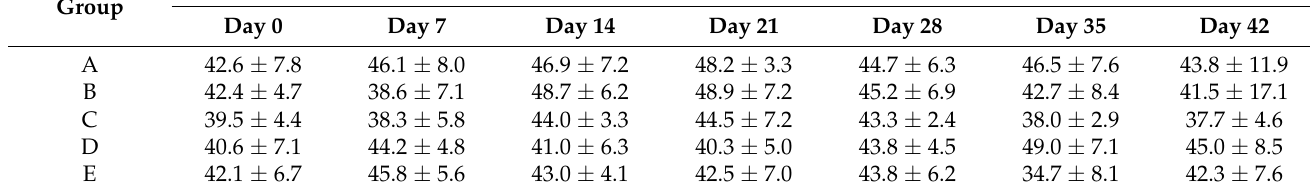
Table 2. Levels of plasma SGPT in rats fed with normal diet throughout 42 days of the experimental period. (A) Fed with normal diet for 14 days, followed by high fat diet for another 14 days, followed by normal diet until Day 42 (B); fed with high fat diet for 14 days, followed by normal diet together with atorvastatin for another 14 days, followed by normal diet without atorvastatin until Day 42 (C); fed with high fat diet for 14 days, followed by normal diet together with 100 mg/kg of methanolic extract for another 14 days, followed by normal diet without the extract until Day 42 (D); and fed with high fat diet for 14 days, followed by normal diet together with 50 mg/kg of methanolic extract for another 14 days, followed by normal diet without the extract until Day